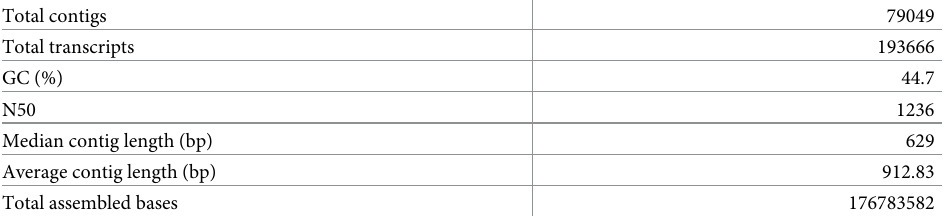
Table 1. Summary of assembly statistics of the ginger transcriptome data.